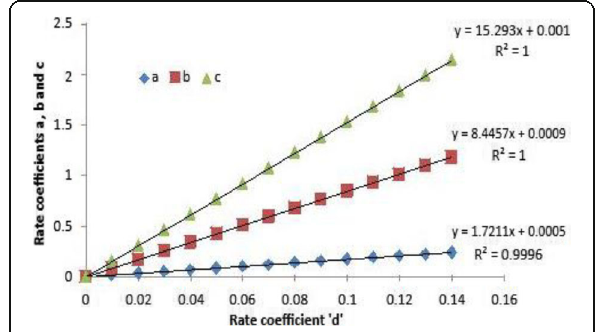
Fig. 7 Increase in rate of conversion of CA (a), SA (b), and FmA (c) with increase in rate of utilization of MA